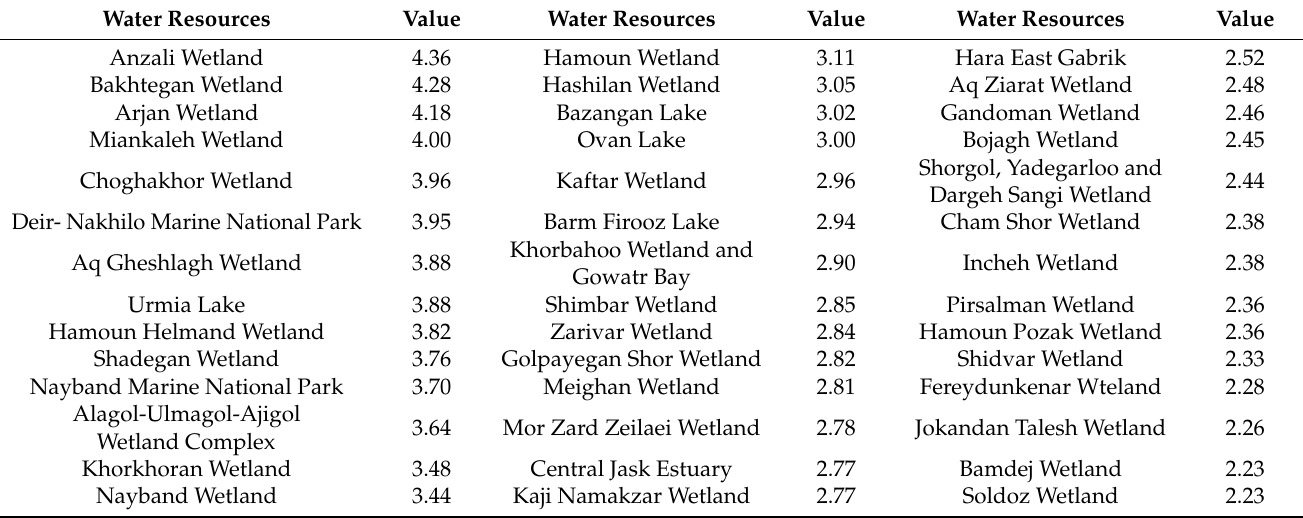
Table 3. Prioritization of the main water resources in Iran based on 5-point expert ratings (1 = very low to 5 = very high) of indicators (see Table 1).